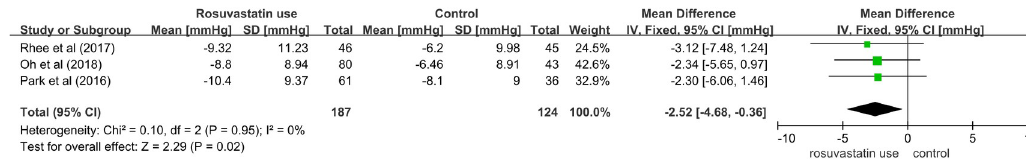
Fig 8. Pooled mean differences for the outcomes of diastolic blood pressure changes in patients with hypertension treated with a triple combination of rosuvastatin plus two antihypertensive agents.